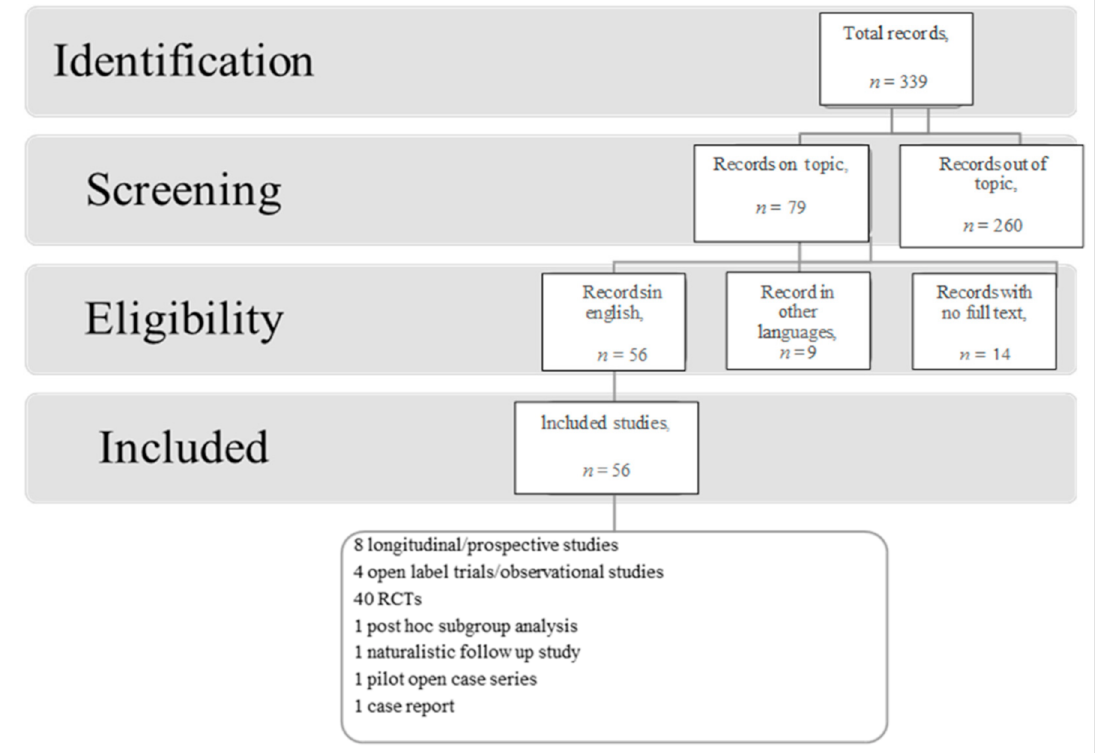
Figure 1. Literature search